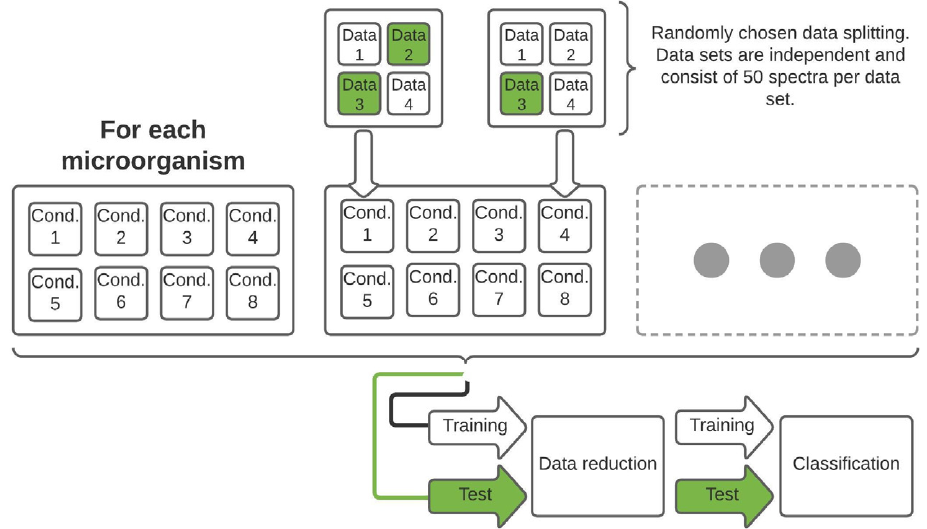
Figure 1. Schematic representation of the data set structure as well as the splitting process with subsequent data reduction and classification. The training and test data set contains the corresponding information of each measured microorganism and thus of each growth and sampling condition.